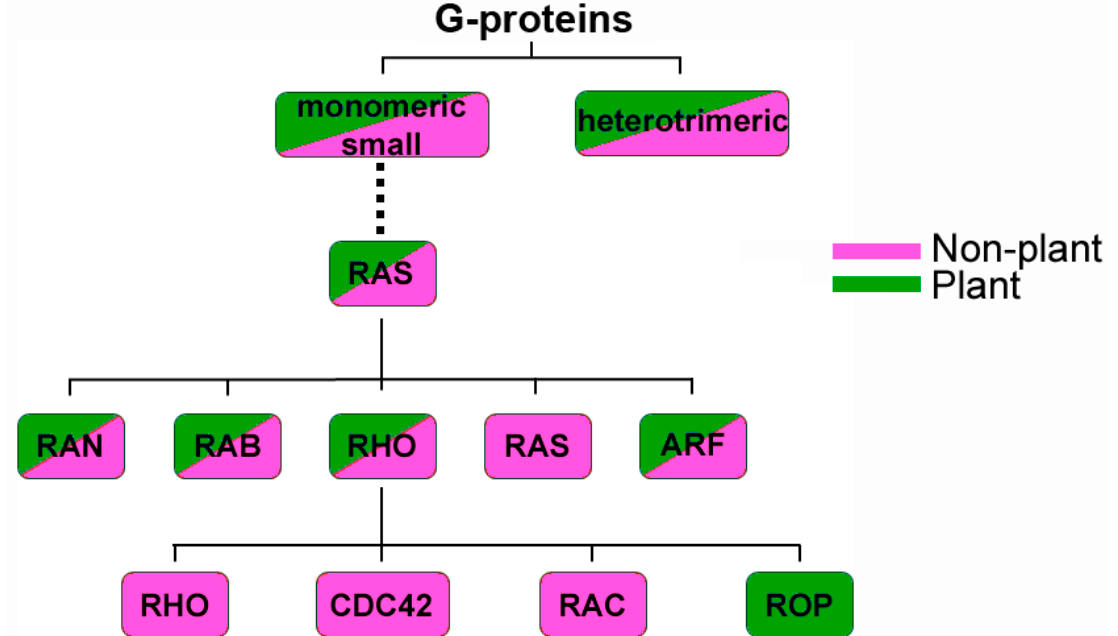
Figure 1. Important classes of G-proteins in eukaryotes. Heterotrimeric versus monomeric small GTPases as present in plants and non-plant eukaryotes (referring only to animals and true fungi here). Rat sarcoma (RAS) proteins are absent from plants, whereas Rho proteins of plants (ROPs) build an exclusive class of Rho family GTPases in plants.